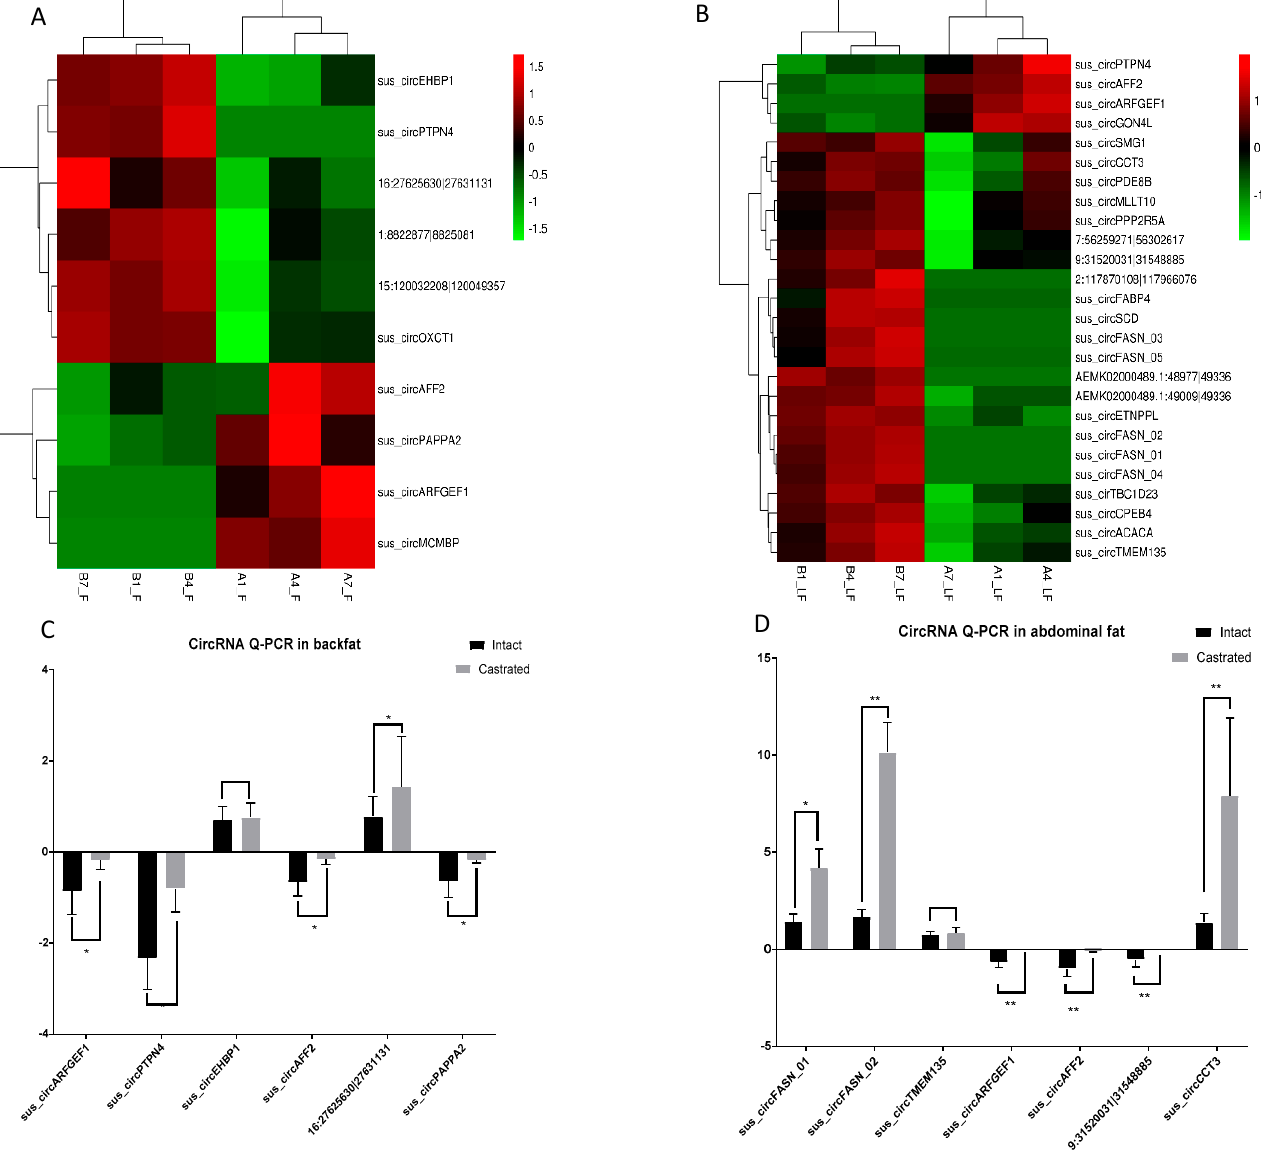
Figure 2. Expression profile of circRNAs. ( A ) Hierarchical cluster analysis diagram of differential circRNAs between AF and BF. ( B ) Hierarchical cluster analysis diagram of differential circRNAs between ALF and BLF. Differentially expressed circRNAs in three pairs, fold change ≥ 2.00 and p ≤ 0.05. ( C ) Quantification of differentially expressed circRNAs between AF and BF. ( D ) Quantification of differentially expressed circRNAs between ALF and BLF. The results are shown as the means ± standard deviation of triplicate measurements. * indicates p < 0.05, ** indicates p < 0.01. AF refers to intact pig backfat tissue, BF refers to castrated pig backfat tissue, ALF refers to intact pig abdominal adipose tissue and BLF refers to castrated pig abdominal adipose tissue.